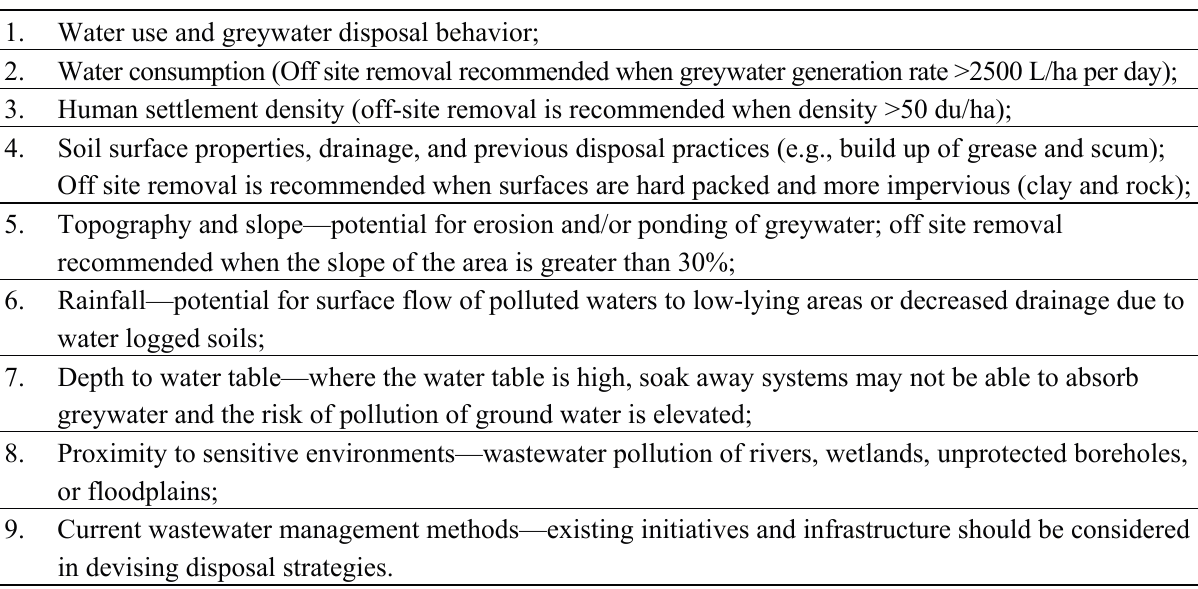
Table 1. Factors Influencing Greywater Management Approaches in non-sewered areas (adapted from Carden et al.